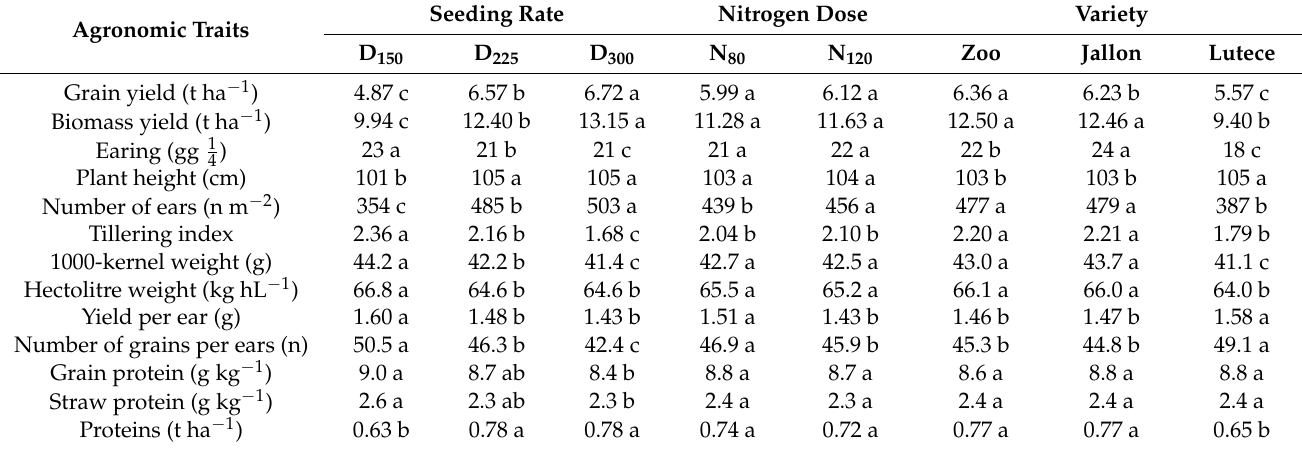
Table 4. Bio-agronomic behaviour of the genotypes under experiment in relation to treatments (fixed effects).